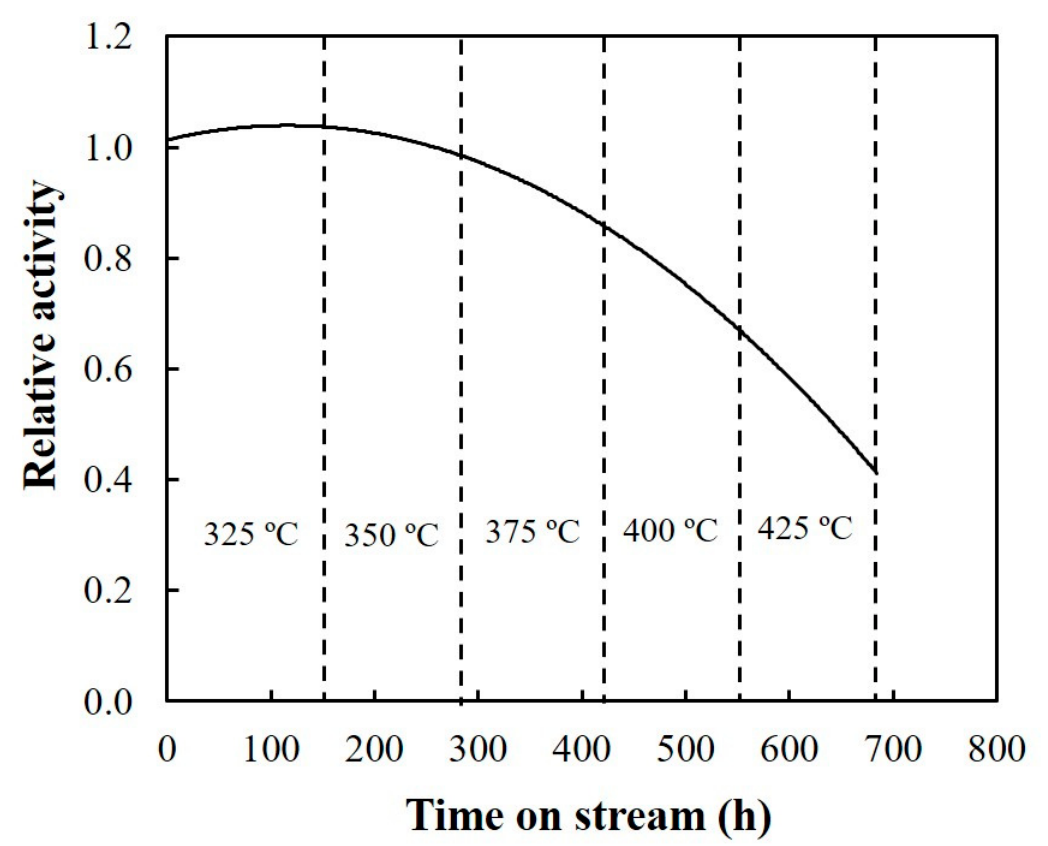
Figure 1. Stability trend of the catalyst with time on stream at different temperature conditions.